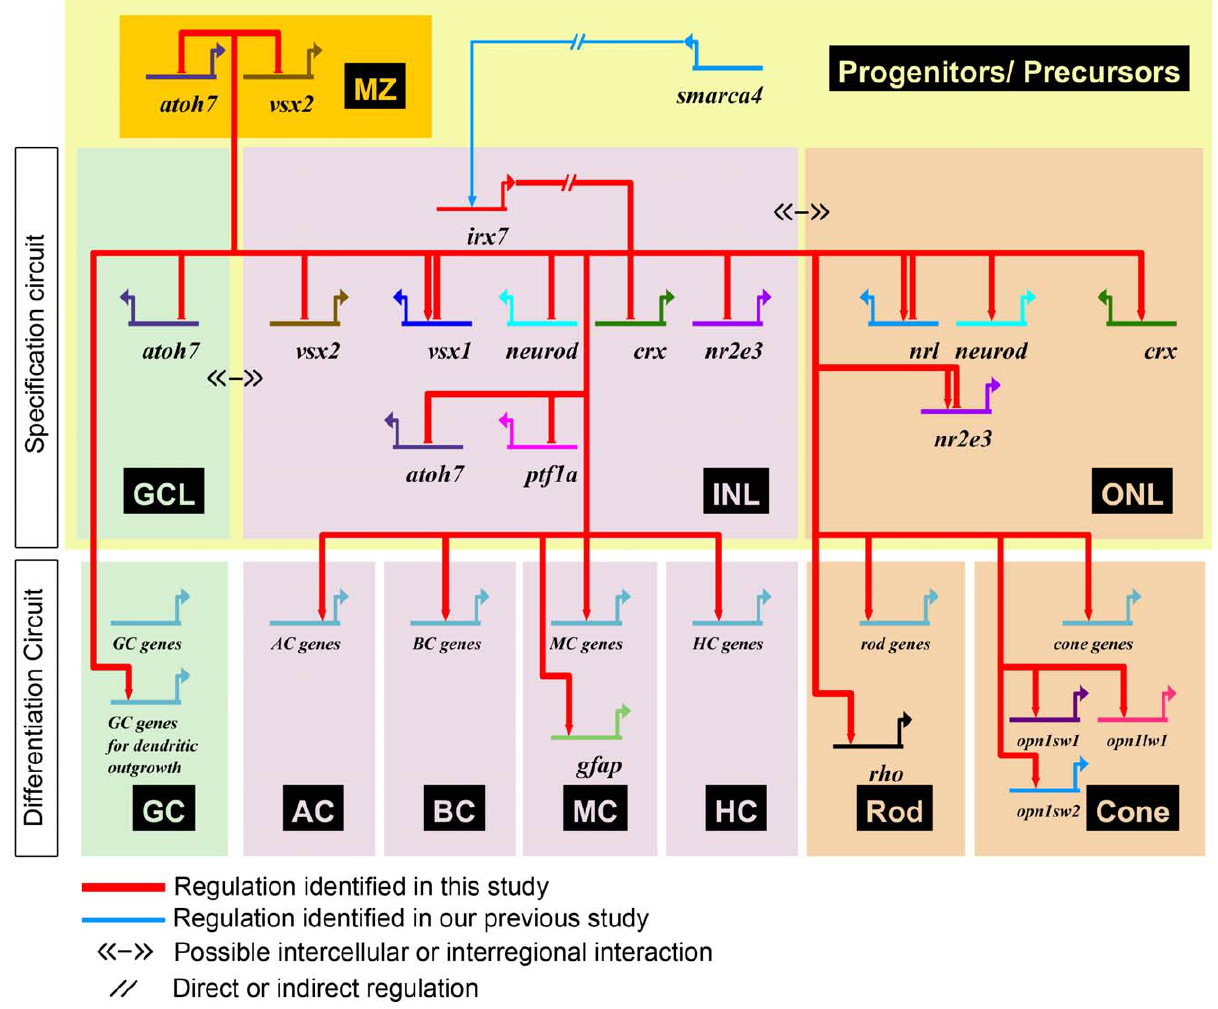
Figure 11. Irx7 gene regulatory network for zebrafish retinal development. A gene regulatory network was constructed using the expression patterns of irx7 downstream targets as characterized in this study. The specification circuit of the network consists of TFs that specify different retinal cell types while the differentiation circuit consists of genes that carry out cell type specific functions. For example, opsins in the photoreceptors are responsible for visual signal transduction. Genes that have not been fully characterized yet are represented by a generic gene ( cell type - genes ) in the differentiation circuit. The activation of these ‘‘ cell type -genes’’ by irx7 , as well as by other TFs, symbolizes the differentiation of the corresponding cell types driven by the specification circuit. For GCs, an additional ‘‘GC genes for dendritic outgrowth’’ is created to distinguish the specific effects of irx7 knockdown on their dendritic outgrowth (Figure 5). If the actual location of the interaction is not well defined, the domain/cell type in which the effector gene is expressed will be used. In addition, different retinal regions, including, GCL, INL and ONL can have cellular interaction ( % - & ) that can trigger signal transduction and in turn modulate gene expression. Note that the network topology is a static global view which consists of information obtained from different stages and studies, thus some genes may have both positive and negative inputs if the regulation is dynamical during development. See File S2 for supporting evidence of the connections and Figure S2 for a comprehensive network with additional connections between these genes as extracted from other literature